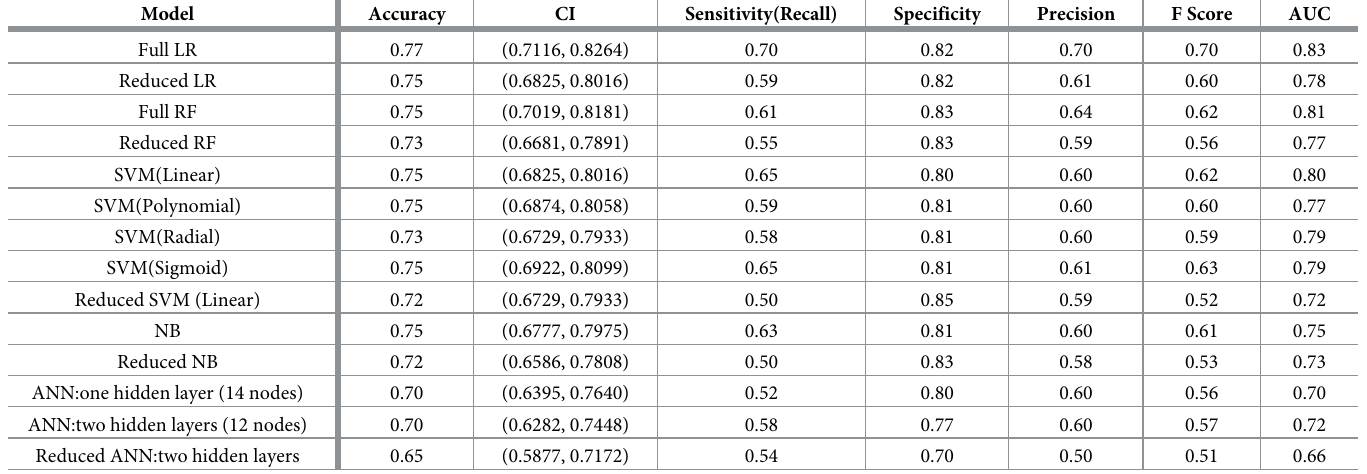
Table 3. 10 fold Cross-validation results of LR, RF, SVM, NB, and ANN.